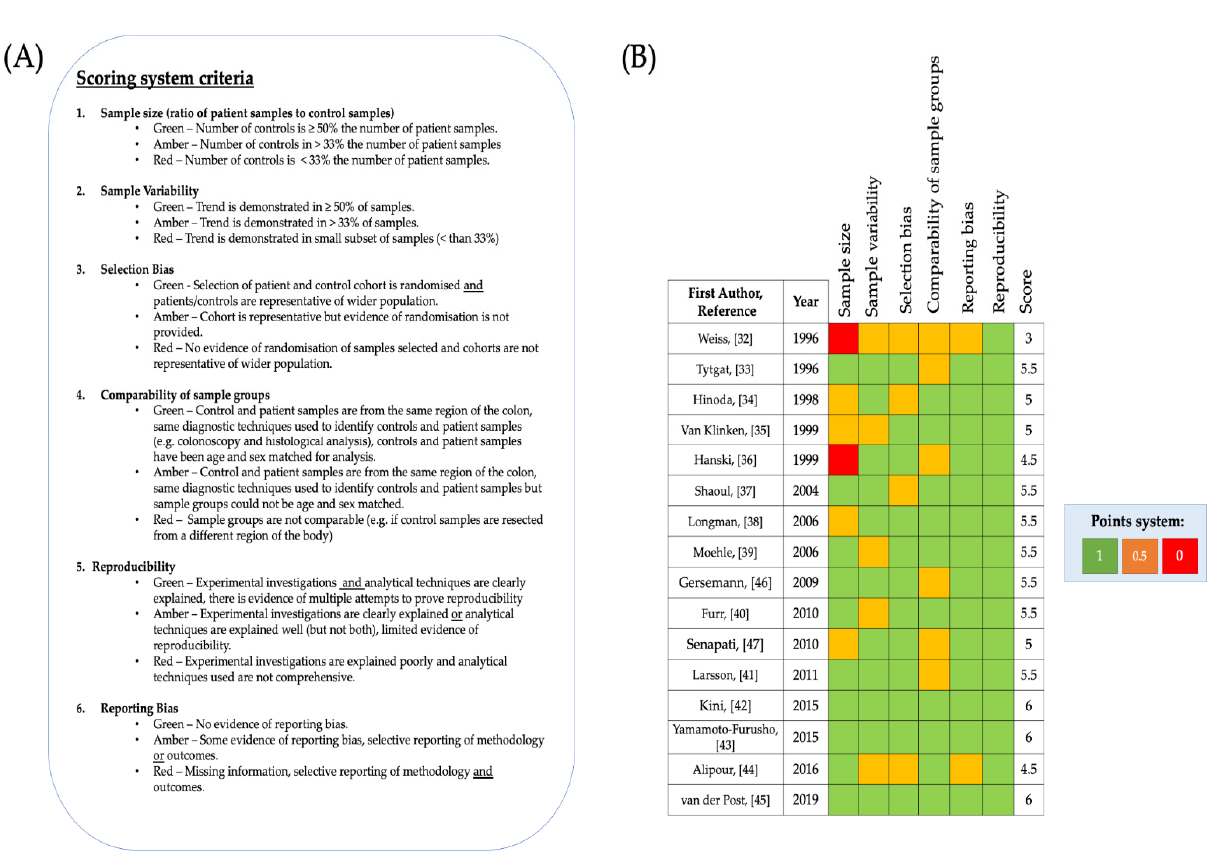
Figure 3. Quality assessment of included studies ( A ) Scoring system used with categories and information outlining how scores were allocated. ( B ) List of included studies and scores allocated to each included study using the quality assessment scoring system is shown.